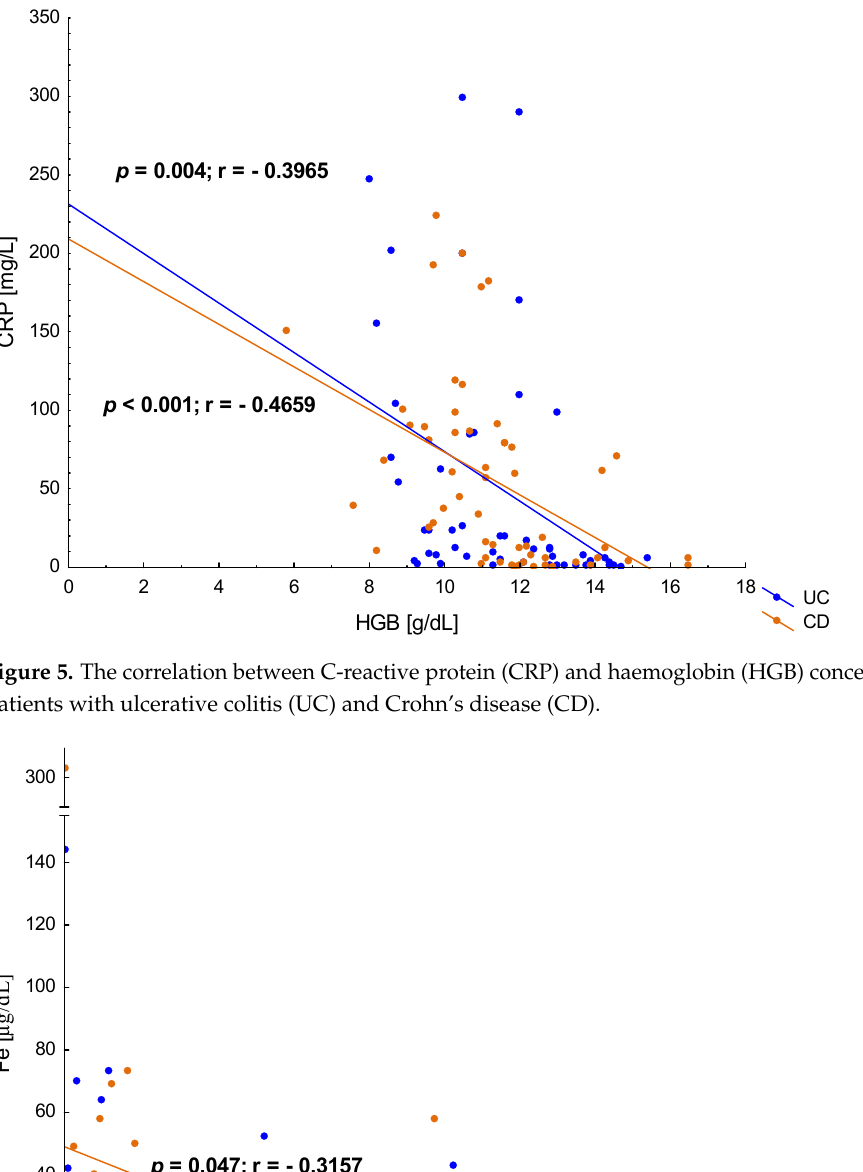
Figure 4. The concentration of hepcidin in patients with ulcerative colitis (UC) and Crohn’s disease (CD) with or without anaemia in relation to the control group.